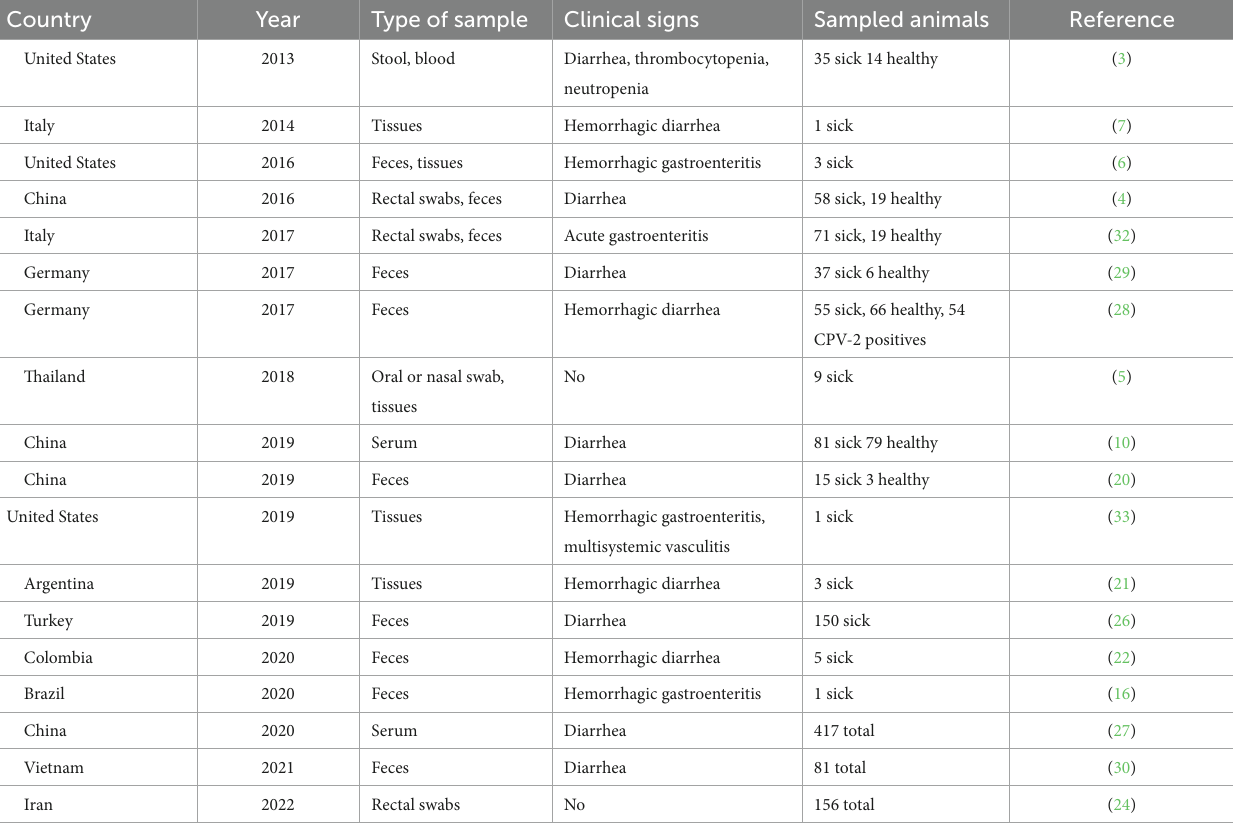
TABLE 1 Studies conducted for the detection of CanineCV in domestic canines.